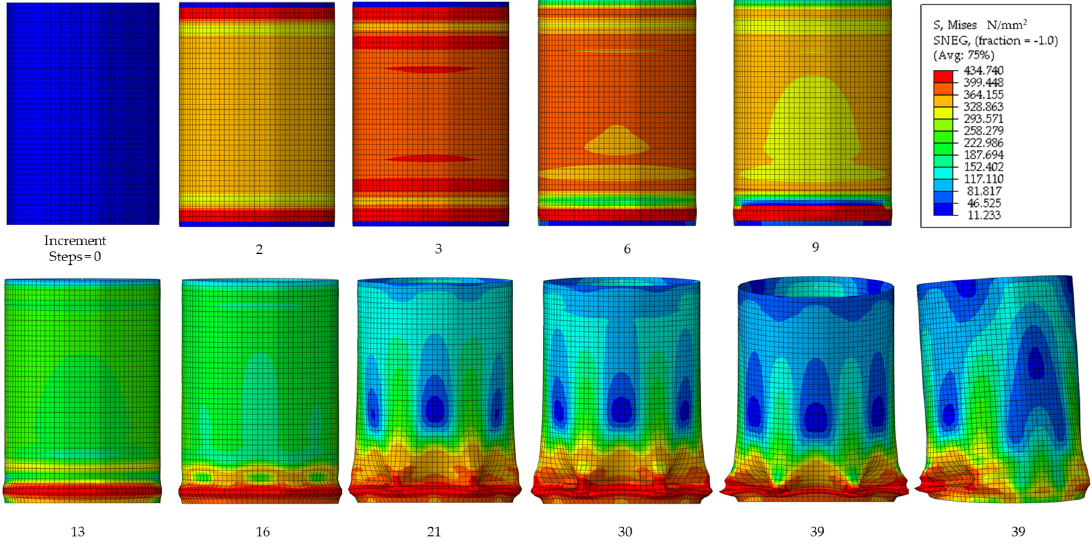
Figure 16. Shell (9 m at 24 mm) stress distributions and deformations at the compressive side of the cylindrical shell at 10 increment steps, and the view of the tension side showing a flattening effect.